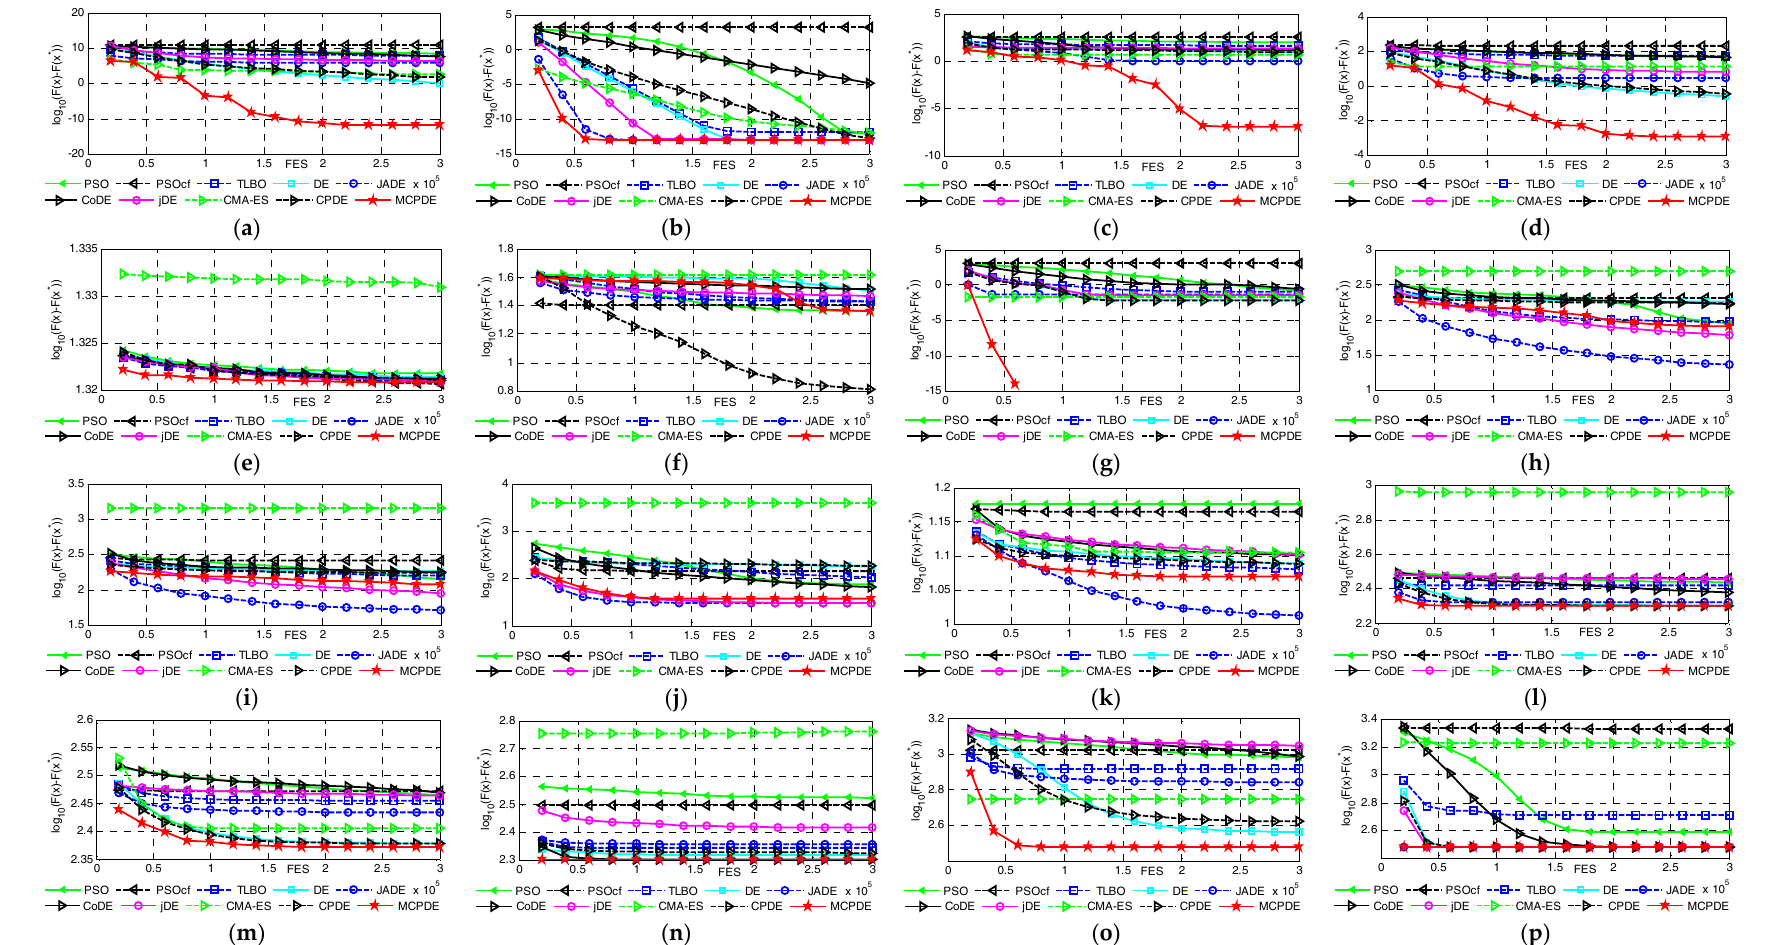
Figure 3. Evolution of the mean function error values derived from PSO, PSOcf, TLBO, DE, JADE, CoDE, jDE, CMA-ES, CPDE and MCPDE versus the number of FES on sixteen test problems with D = 30. ( a ) f 3 ; ( b ) f 5 ; ( c ) f 6 ; ( d ) f 7 ; ( e ) f 8 ; ( f ) f 9 ; ( g ) f 10 ; ( h ) f 12 ; ( i ) f 13 ; ( j ) f 17 ; ( k ) f 20 ; ( l ) f 24 ; ( m ) f 25 ; ( n ) f 26 ; ( o ) f 27 ; ( p ) f 28 .